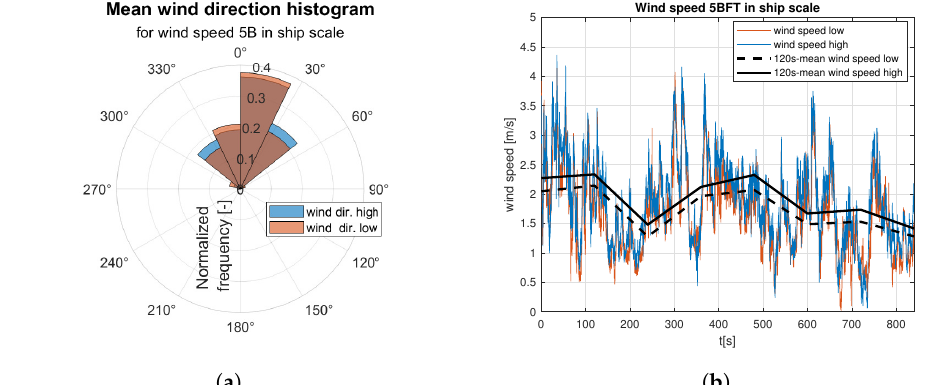
Figure 10. Raw measurements for medium weak wind—5BFT in ship scale: ( a ) wind rose; ( b ) time